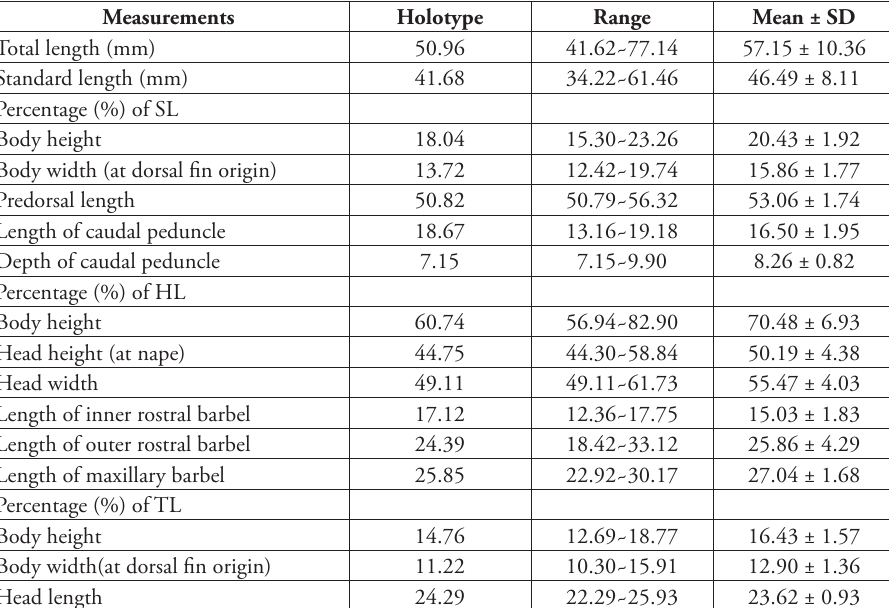
Table 2. Main morphometric characters of O. daqikongensis sp.